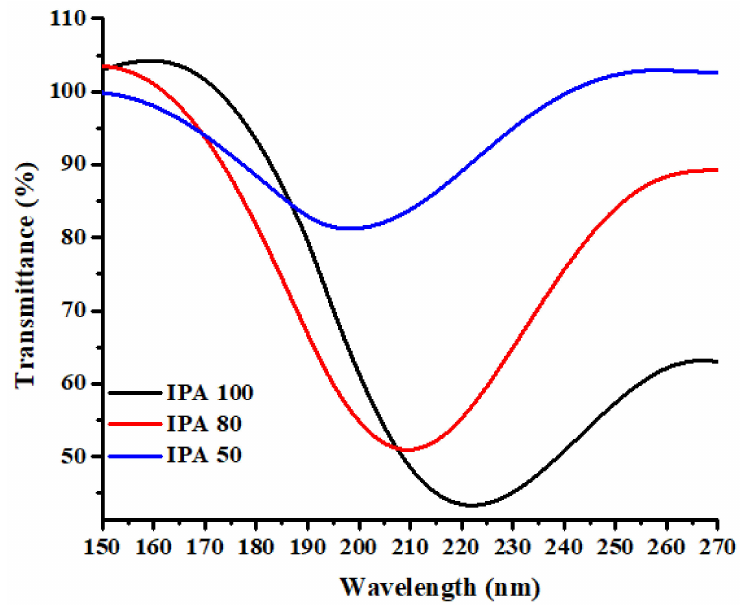
Figure 8. Transmittance spectra at various concentrations.